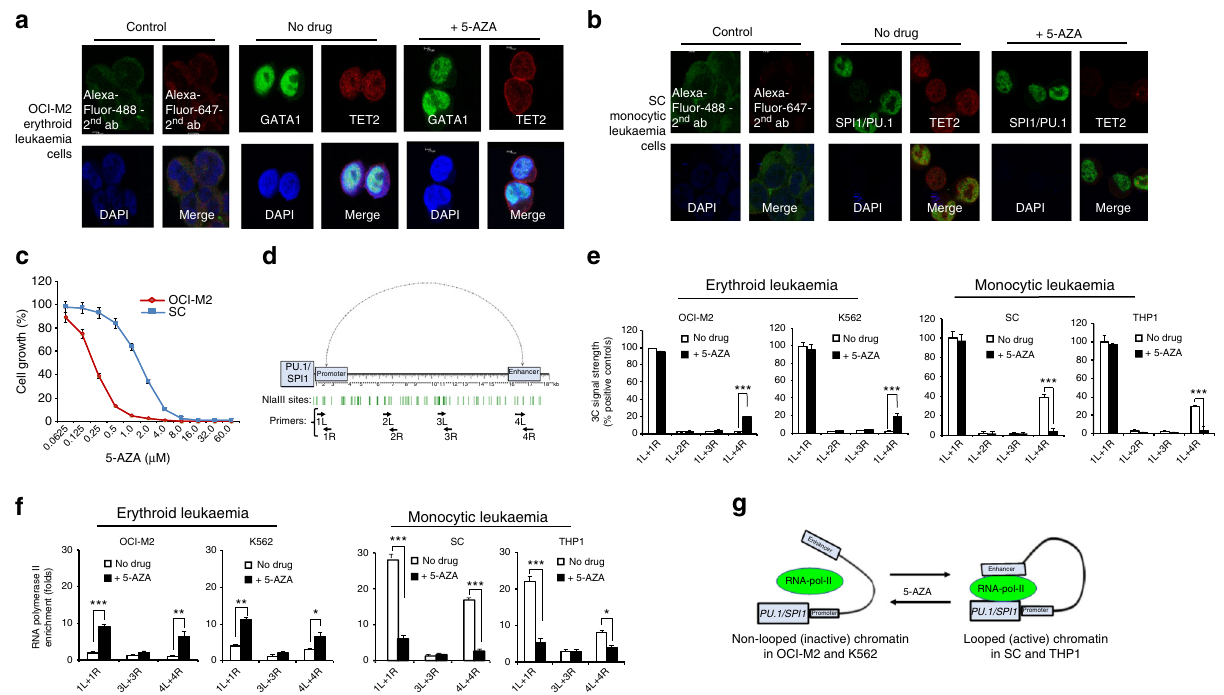
Fig. 3 Lineage-associated drug-responsive chromatin structural changes in leukaemia cells. a STED confocal microscopy analysis of the subcellular localization and co-localization of GATA1 and TET2 in OCI-M2 cells with no drug and 1 μ M 5-AZA for 3 h. b STED confocal microscopy analysis of the subcellular localization and co-localization of GATA1 and TET2 in SC cells with no drug and 1 μ M 5-AZA for 3 h. c Differential growth inhibition of OCI-M2 and SC leukaemia cells induced by 1 μ M 5-AZA for 3 days. d A schematic illustration of the locations of the PCR primers designed in the regulatory region of SPI1/PU . 1 . e The PCR signals detected by 3C assays in the erythroid leukaemia cell lines, OCI-M2 and K562, and the monocytic leukaemia cell lines, SC and THP1, with no drug and 1 μ M 5-AZA for 3 h. f ChIP assays with an antibody against the active form (CTD-S2P/S5P) of RNA-pol-II at the SPI1/PU . 1 locus in the OCI-M2, K562, SC and THP1 cells, with no drug and 1 μ M 5-AZA for 3 h. g A schematic summary of these data suggesting opposite transformations of the chromatin conformation at SPI1/PU . 1 in erythroid vs. monocytic leukaemia cells in response to 5-AZA. Data are presented as the mean ± SEM of n = 3 independent samples. * P < 0.05, ** P < 0.01 and *** P < 0.001 by Student ’ s t leukaemia cells (Fig. 5c). 5-AZA rapidly dissociated hnRNPK PU.1 (in SC) as IP “ baits ” to identify the interacting RNP(s). We from the RNA-pol-II/CDK9/7 complex within 10 – 20 min, while identi fi ed hnRNPK as a unique RBP that directly interacted with the expression of these proteins remained unchanged (Fig. 5d). In both GATA1 and TET2, whereas other RNPs, such as hnRNPA1 contrast, the interactions between hnRNPK and DNMT2 as well and AUF1, did not bind GATA1 (Fig. 4f). A similar pattern of the as NSUN3 were insensitive to 5-AZA in the same leukaemia cells interactions between hnRNPK and SPI1/PU.1 as well as TET2 (Fig. 5e). Based on all the above-described data, we hypothesized was observed in SC cells (Supplementary Fig. 6). Together, these a working model of the hnRNPK/RCMT-mediated lineage-asso- data demonstrate that RNA/hnRNPK mediates 5-AZA-sensitive ciated, 5-AZA-sensitive active chromatin structure at nascent interactions between the lineage-determining TFs and chromatin RNA in leukaemia cells and a novel 5-AZA action mechanism modi fi ers in leukaemia cells as schematically illustrated in Fig. 4g. through disruption of the hnRNPK-associated active chromatin structure (Fig. 5f). hnRNPK binds CDK9 to form 5-AZA-sensitive active chro- matin . CDK7/TFIIH and CDK9/P-TEFb can phosphorylate the serine 5 and serine 2 residues in the C-terminal domain (CTD) of To explore the role of the RNA-pol-II and RCMT complexes in 5- RNA-pol-II, i.e. CTD-S5P and CTD-S2P, which are critical for AZA resistance, we compared the expression levels of the com- transcription initiation and elongation, respectively 24, 36 . Western blotting showed that 5-AZA signi fi cantly reduced CTD-S2P in ponents of these complexes. Western blotting demonstrated a OCI-M2 cells within 1.5 h while levels of total RNA-pol-II, CTD- small increase (~1 – 2 fold) in the expression of total RNA-pol-II, S5P, RCMTs, hnRNPK CDK9/P-TEFb and CDK7 remained CTD-S2P, CDK7, CDK9/P-TEFb, BRD4 and BRD2 in the 5- unchanged (Fig. 5a). RNase digestion-coupled IP and co-IP AZA-resistant M2AR and SCAR leukaemia cells compared to the revealed a direct interaction between hnRNPK and CDK9/P- original 5-AZA-sensitive OCI-M2 and SC leukaemia cells TEFb and indirect interactions between hnRNPK and CDK7/ (Fig. 6a). As expected, the 5-AZA-resistant M2AR leukaemia cells TFIIH as well as RNA-pol-II CTD-S2P in the OCI-M2 leukaemia had markedly increased (~20 fold) hnRNPK-associated RNA-pol- cells (Fig. 5b). By employing a newly developed 5-ethynyluridine II CTD-S2P compared to ASLCs (Fig. 6b). To our surprise, the (EU) clicking chemistry technology 37 and STED confocal markedly increased interactions between hnRNPK and CTD-S2P microscopy, we demonstrated co-localization of hnRNPK and as well as GATA1 in the 5-AZA-resistant M2AR leukaemia cells active RNA pol-II (CTD-S2P) at nascent RNA, and the co- were still highly sensitive to 5-AZA, and 5-AZA rapidly disrupted localization was markedly increased in the 5-AZA-resistant these interactions within 10 min in these cells (Fig. 6b), suggesting M2AR cells compared to the 5-AZA-sensitive OCI-M2 an hnRNPK-independent mechanism for 5-AZA-resistance.